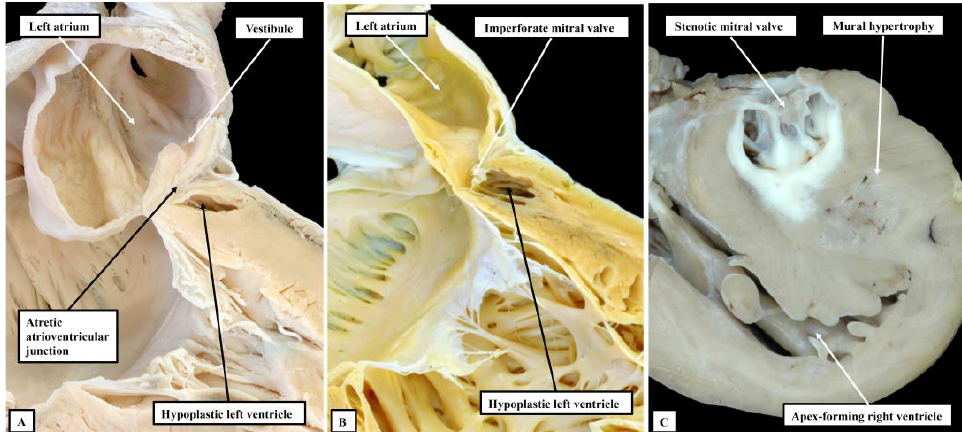
Figure 4. The images show the sequence of development of the mitral valve in the setting of hypoplastic left heart when the syndrome is defined on the basis of an intact ventricular septum. In panel ( A ), the atrioventricular connection had been formed, as evidenced by the presence of a blind-ending vestibule in the floor of the left atrium, but has become atretic. Panel ( B ) shows an imperforate mitral valve closing off a perforate left atrioventricular junction, while panel ( C ) shows a stenotic valve. Note that, in the setting of the stenotic valve, the cavity of the hypoplastic left ventricle is lined by a dense layer of fibroelastosis. Such elastosis is lacking in the hypoplastic left ventricles seen in panels ( A , B